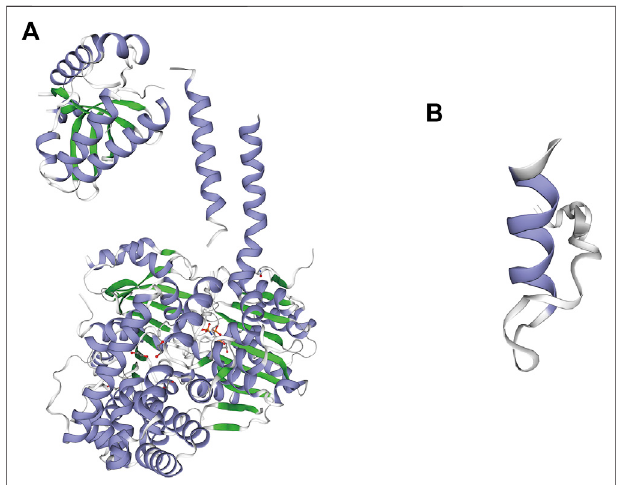
FIGURE 2 | Difference between the wild-type and p.E5Afs*37 (c.12_13del) mutant protein of SKIV2L . (A) Three-dimensional model of wild- type SKIV2L . (B) Model of the mutant